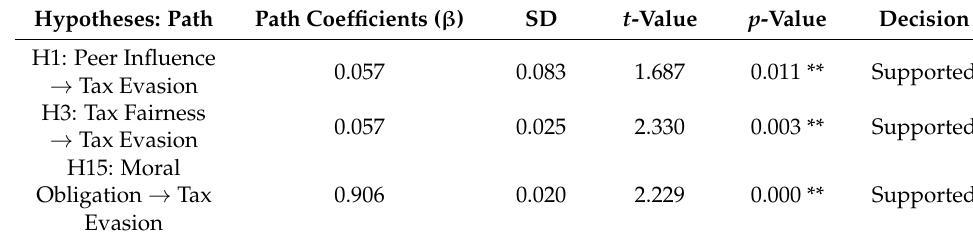
Table 4. Path coefficients of the exogenous constructs predicting tax evasion.